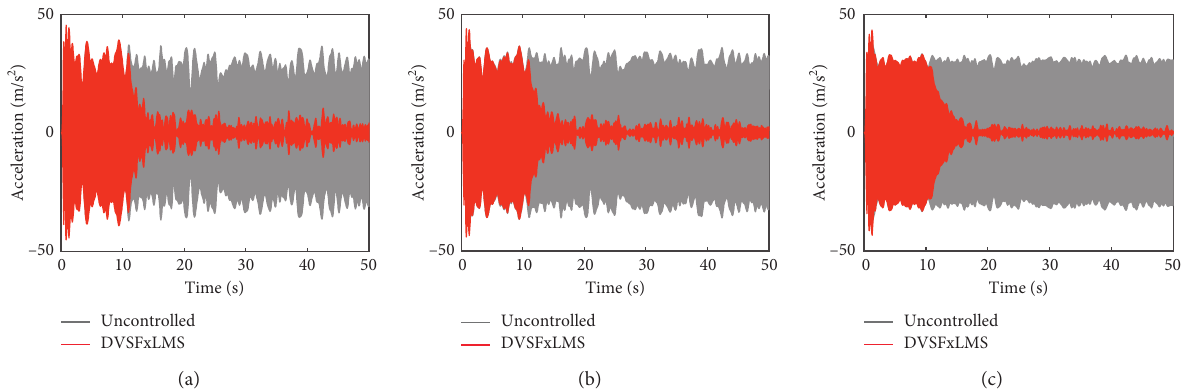
Figure 11: Experimental results of the DVSFxLMS controller under harmonic excitation with superimposed noise: acceleration response at point A. (a) σ 2 � 1, (b) σ 2 � 0.25, and (c) σ 2 �